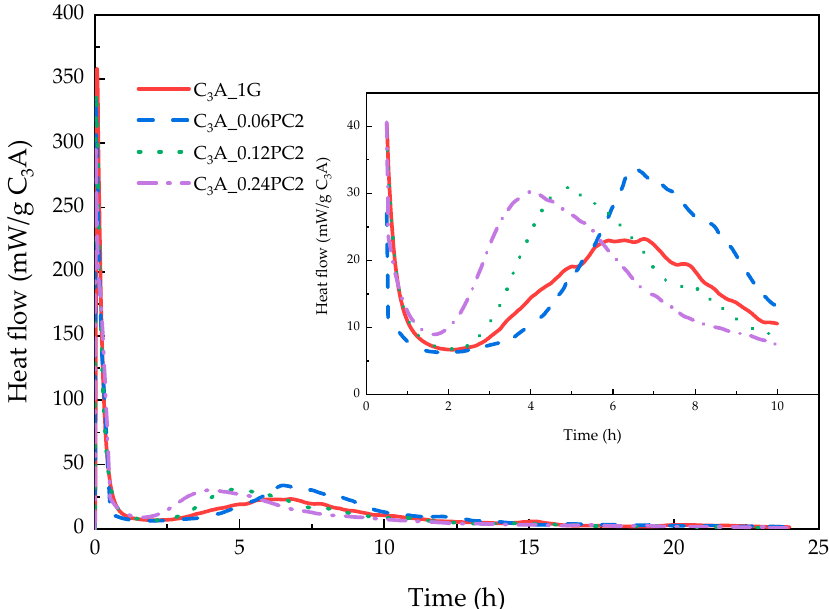
Figure 6. Heat evolution curves of C 3 A-gypsum with different concentrations of PC2 solution during the 24-h hydration.